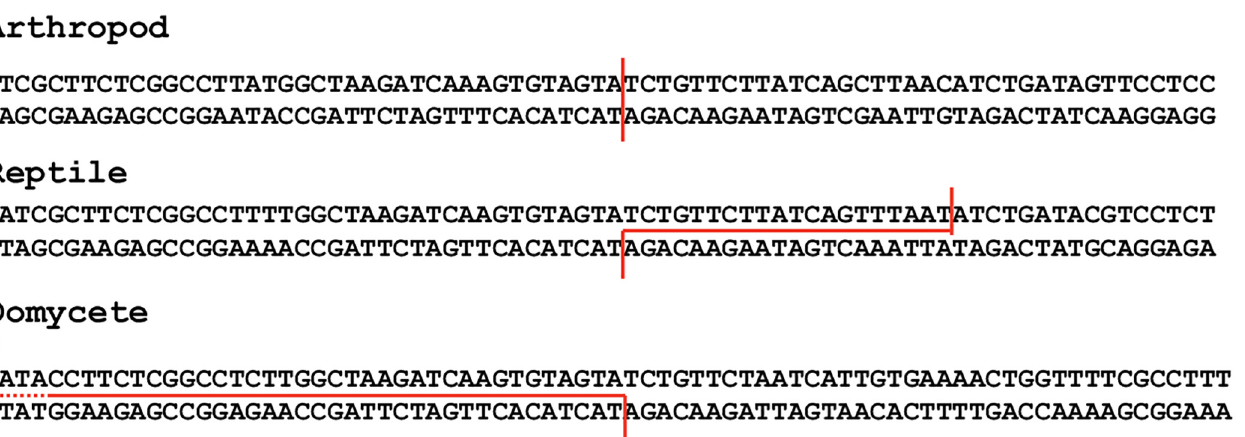
Fig 2. Putative cleavage sites for Utopia elements. Red lines indicate the cleavage sites based on the target site alterations upon insertions. Top strand cleave site is unclear for oomycete Utopia families due to the diversity of the 5 ’ flanking sequences of U2 genes.